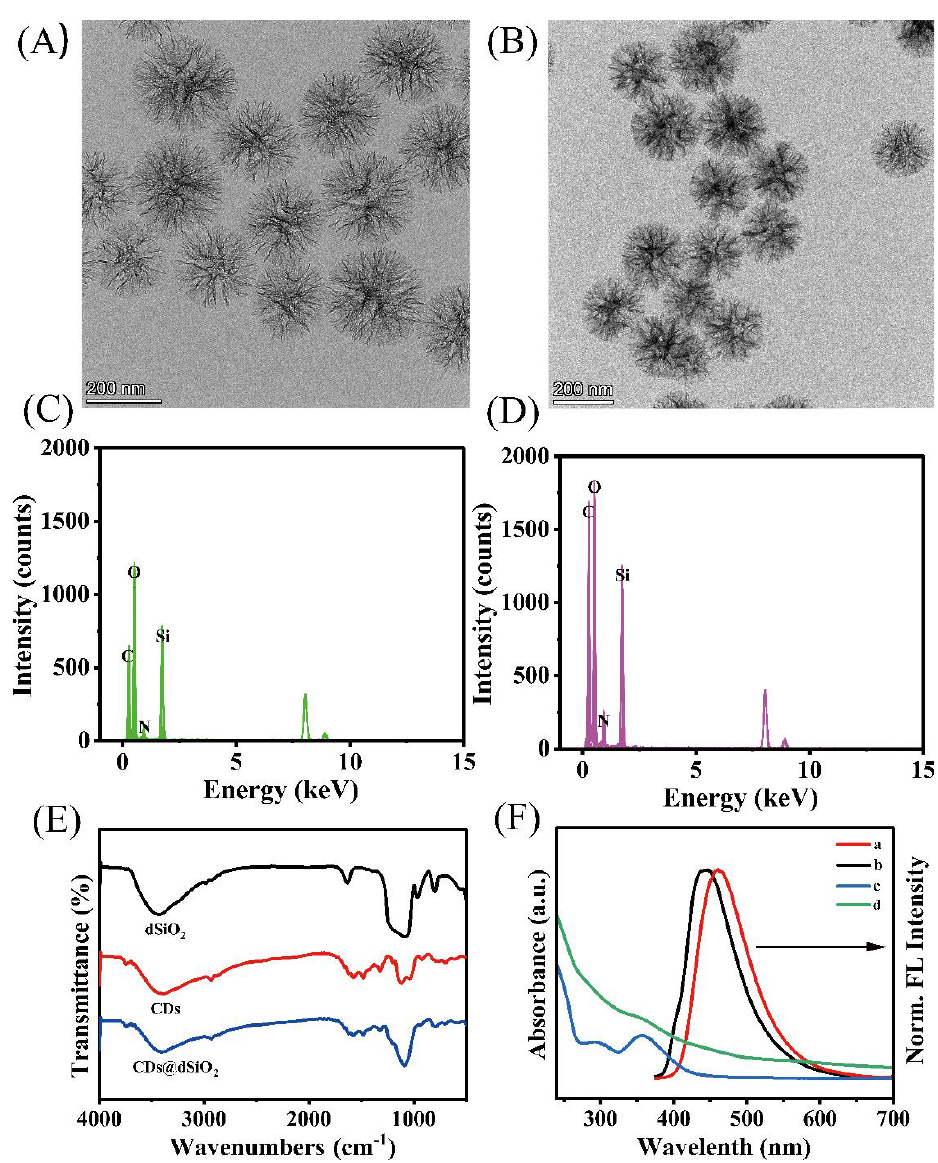
Figure 2. TEM images and EDX of ( A , C ) dSiO 2 , ( B , D ) CDs@dSiO 2 ; ( E ) FTIR spectra of dSiO 2 NPs, CDs, CDs@dSiO 2 NPs, respectively, and ( F ) UV–vis absorption spectrum and fluorescence spectrum of (a, c) CDs, and (b, d) CDs@dSiO 2